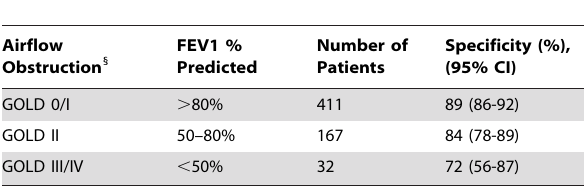
Table 9. Classifier specificity by level of airflow obstruction.